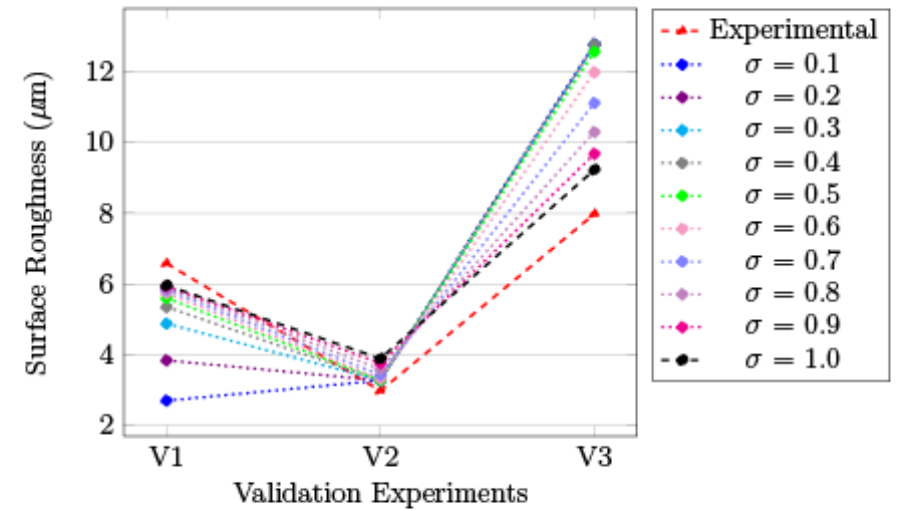
Figure 15. GRNN model testing for Ra with different smoothing factors.